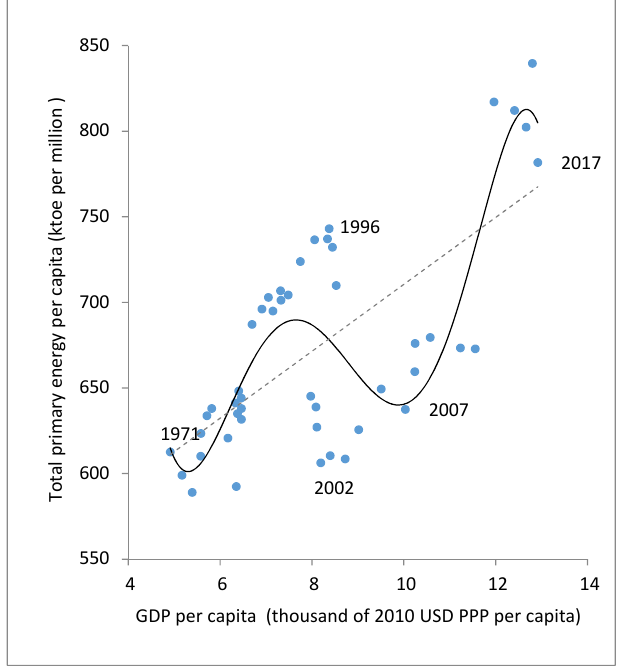
Figure 3. Relationship between energy and GDP. (Source: Produced by the authors with IEA data [3]).